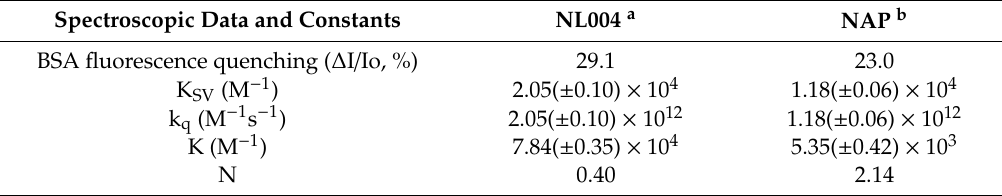
Table 2. Comparison of the spectroscopic data (% of BSA fluorescence quenching), the quenching and the binding constants of NL004 and NAP for BSA (k q , K).